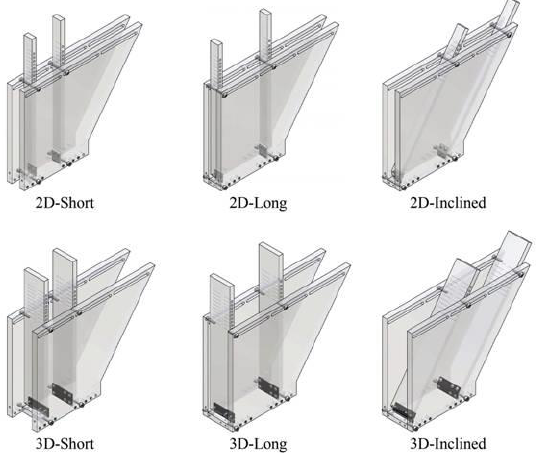
Figure 7. Feeding tank configurations as compared by Ramírez-Aragón et al., adapted with permission from [65]; published by Elsevier, 2018.